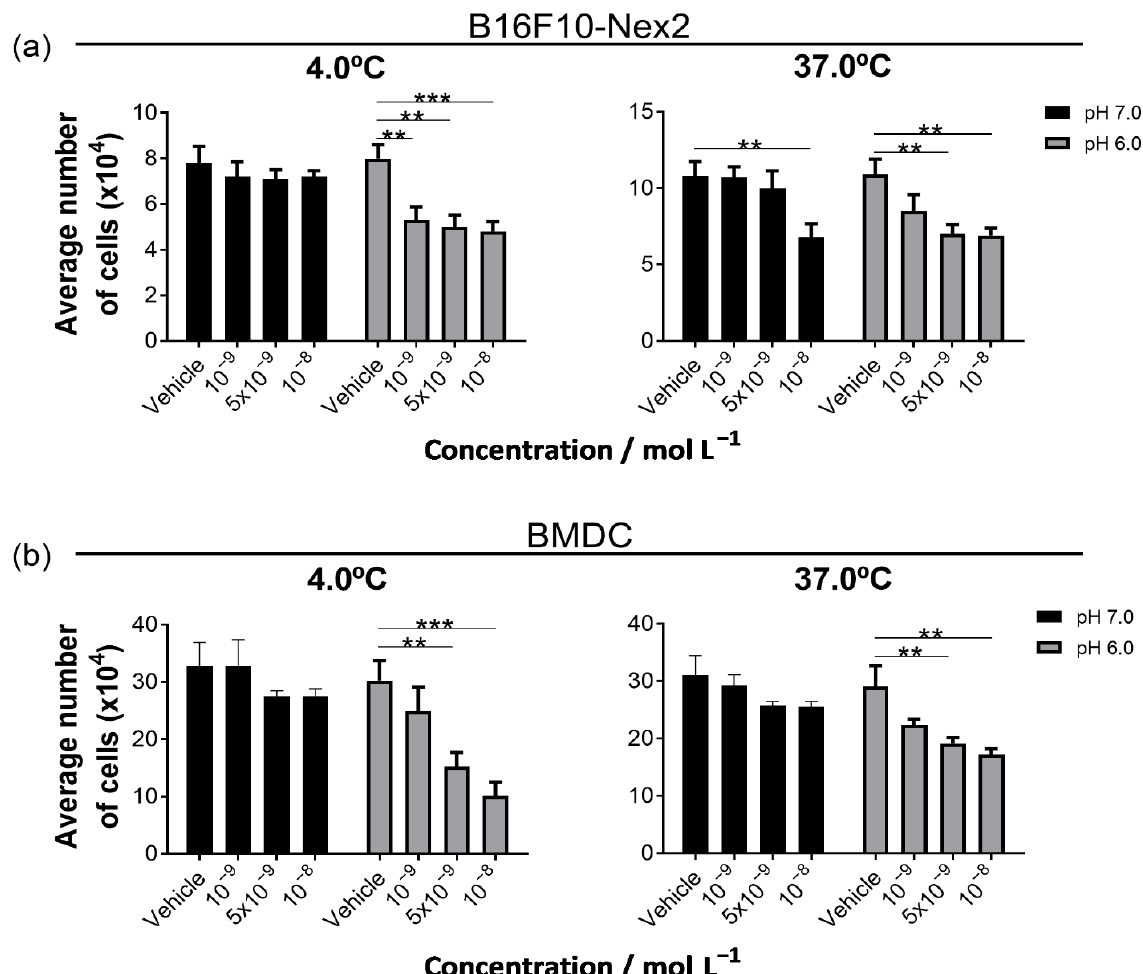
Figure 4. Toxicity evaluation of MNP@QD in melanoma cells ( a ) and in BMDCs ( b ) cultured either at pH 7.0 or pH 6.0, at 4 °C and 37 °C. Cell viability was assessed with the Trypan Blue method. Each bar represents the average of five replicates. Error bars represent SEM. Graphs are representative of three independent experiments. ** p < 0.01; *** p < 0.001 Statistical significance was obtained with 2way ANOVA with Dunnet’s multiple comparisons test.